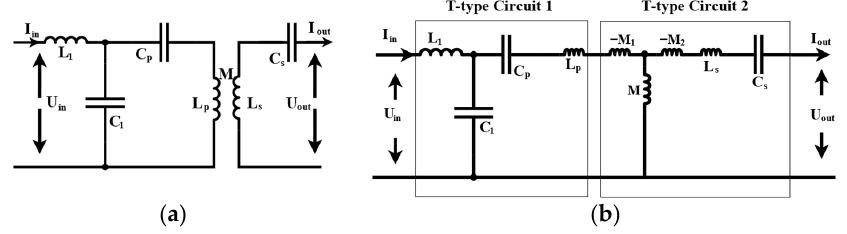
Figure 4. ( a ) LCCL-S resonant compensation topology, ( b ) Equivalent circuit for the LCCL-S topol- ogy.